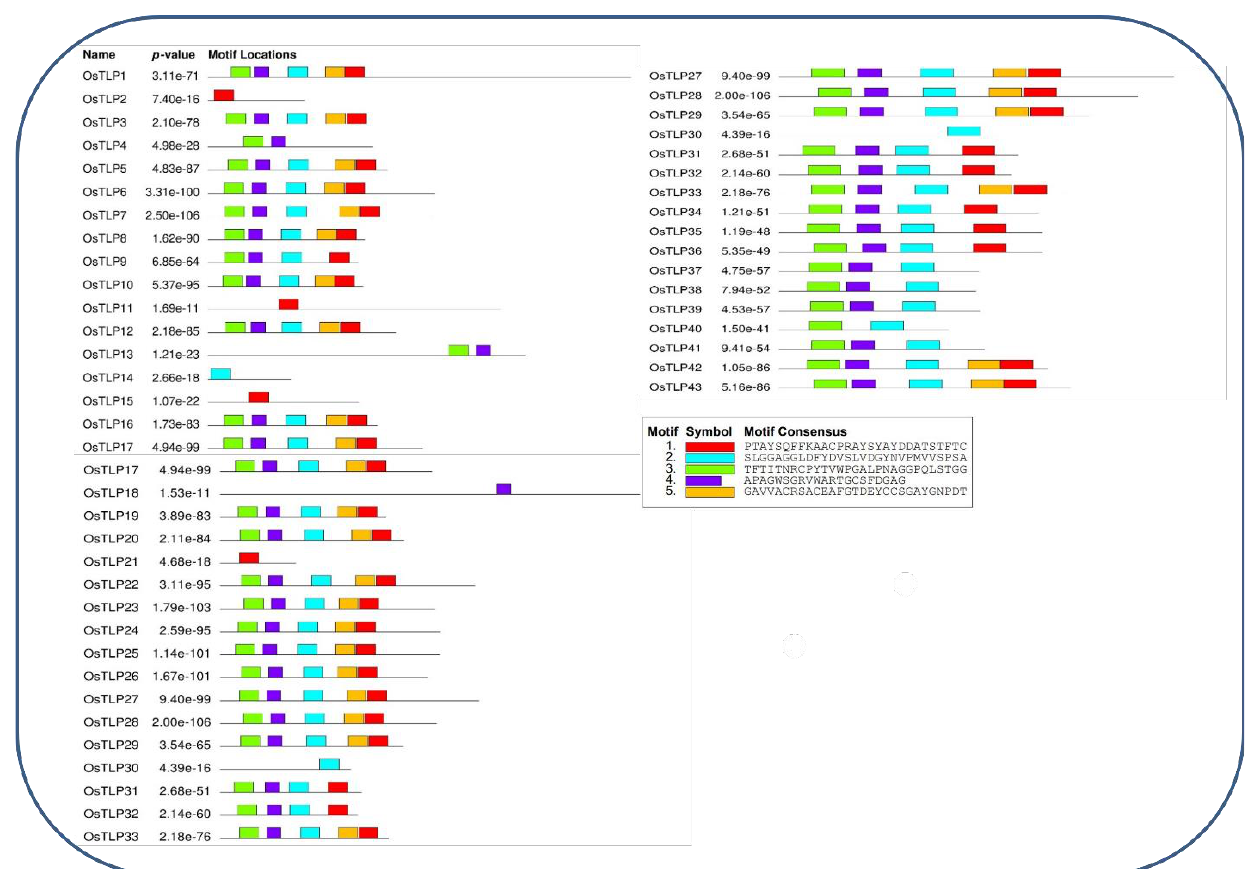
Figure 3. Schematic representation of the conserved motif of TLP genes in Oryza sativa .